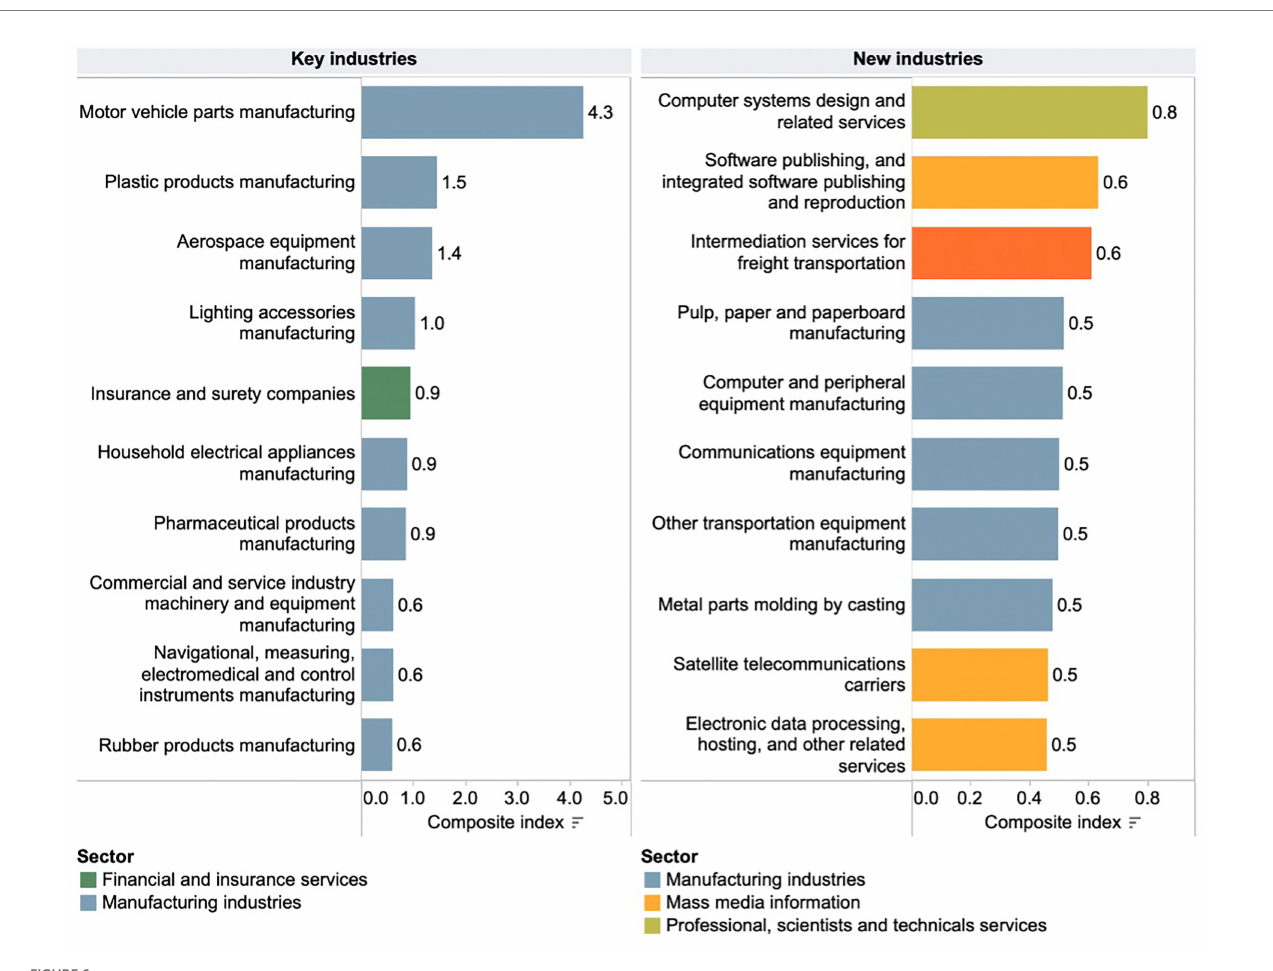
FIGURE 6 Top 10 key new industries of the MAQ. Own